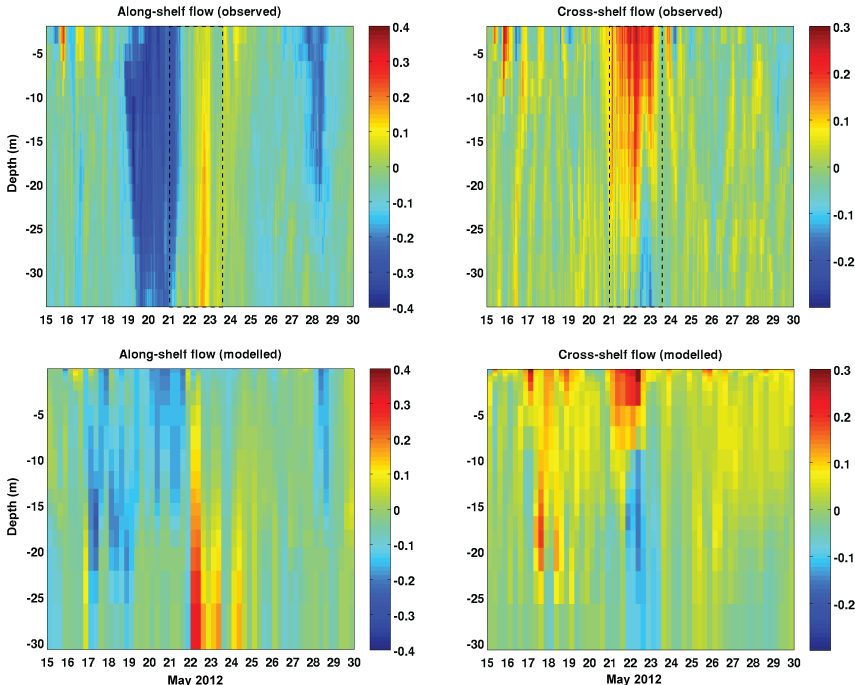
Figure 8. Along-shelf (left panels) and cross-shelf (right panels) velocity observed (top panels) and modelled (bottom panels) during May 2012 (in ms − 1 ). Positive means north-eastward and offshore. The wind jet period is marked as a dashed square in the observed values. Note the different velocity ranges between cross-shelf and along-shelf